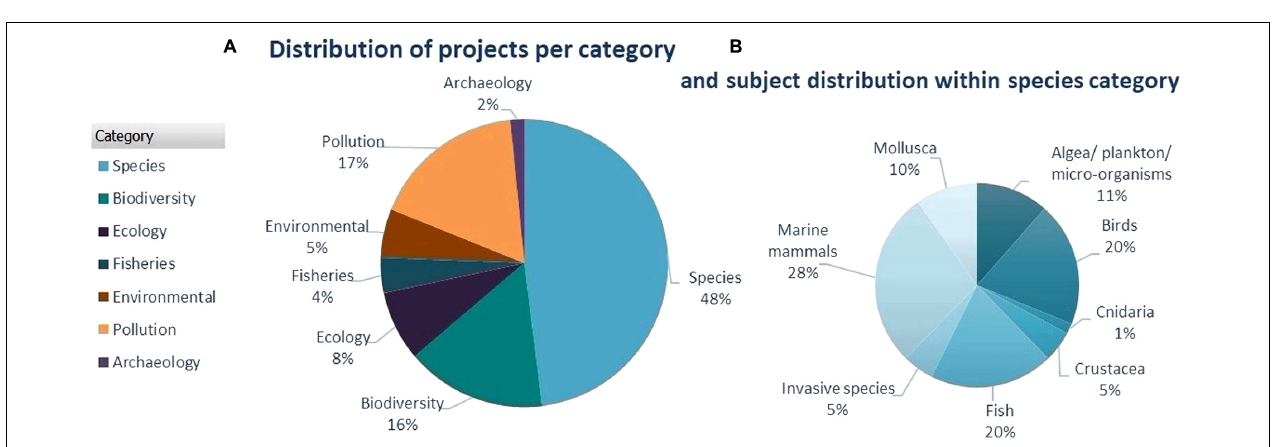
FIGURE 2 | (A) Distribution of marine citizen science projects by topic categories in the North Sea and (B) Subject distribution within the “species” category (from van Hee et al.,